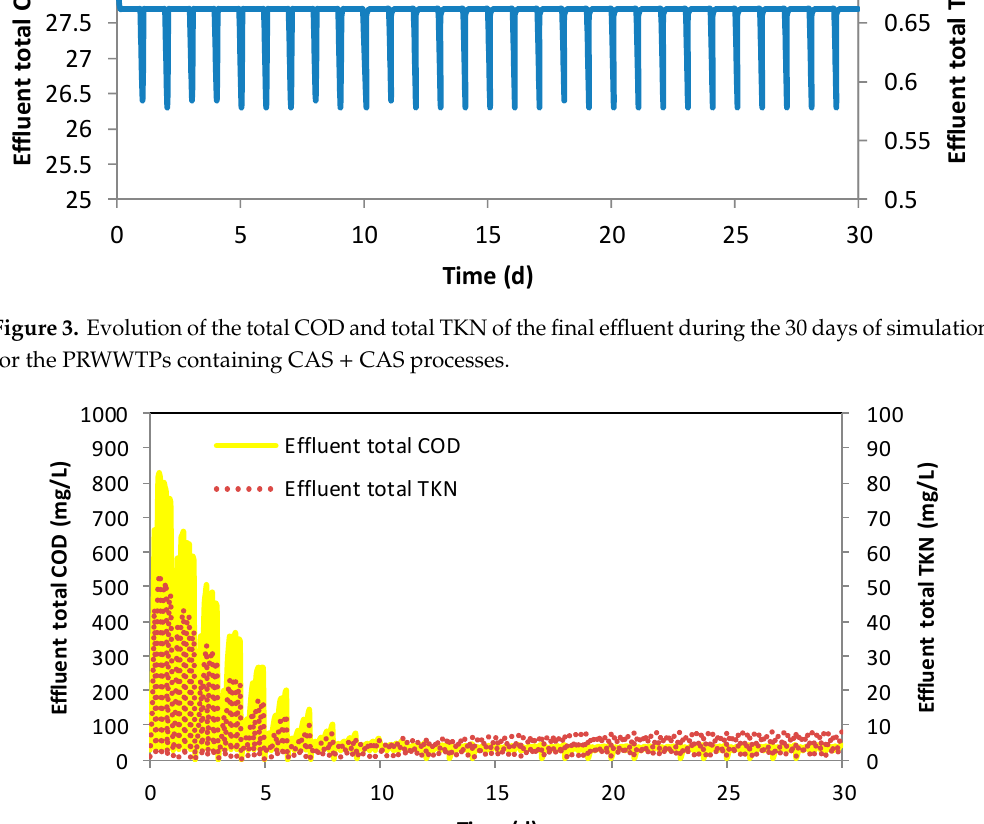
Figure 4. Evolution of the total COD and total TKN of the final e ffl uent during the 30 days of simulation